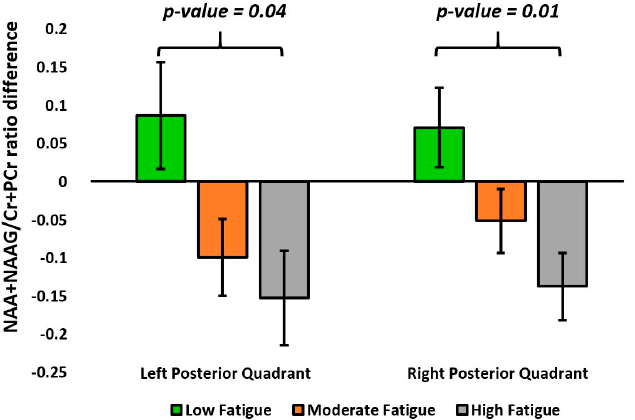
Figure 6. Bar graphs representing the mean and standard error of mean (SEM) of the NAA+NAAG/Cr+PCr ratio difference (year 1 minus baseline) in the left posterior quadrant (LPQ) and right anterior quadrant (RPQ) between the fatigue groups. The p -value represents the statistical significance of pairwise comparisons in the one-way ANOVA. Table 3. One-way ANOVA of the NAA+NAAG/Cr+PCr ratio difference between the fatigue groups.